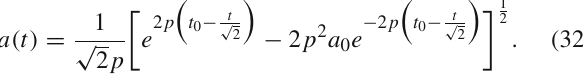
and U 0 = 2. For the 2